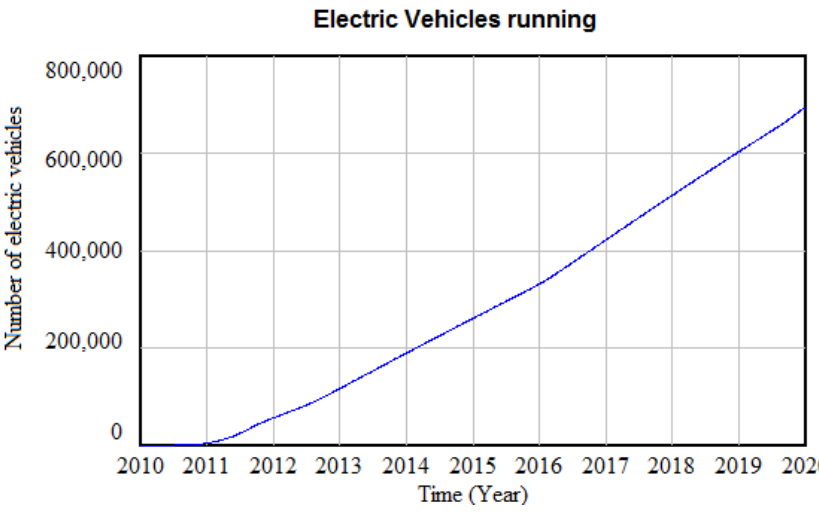
Figure 10. TON of CO